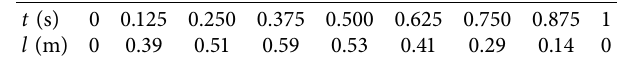
2 , (b) KCl, and (c) NH 4 H 2 PO 4 . Table 2: Flame propagation distance at diferent times after the explosion.